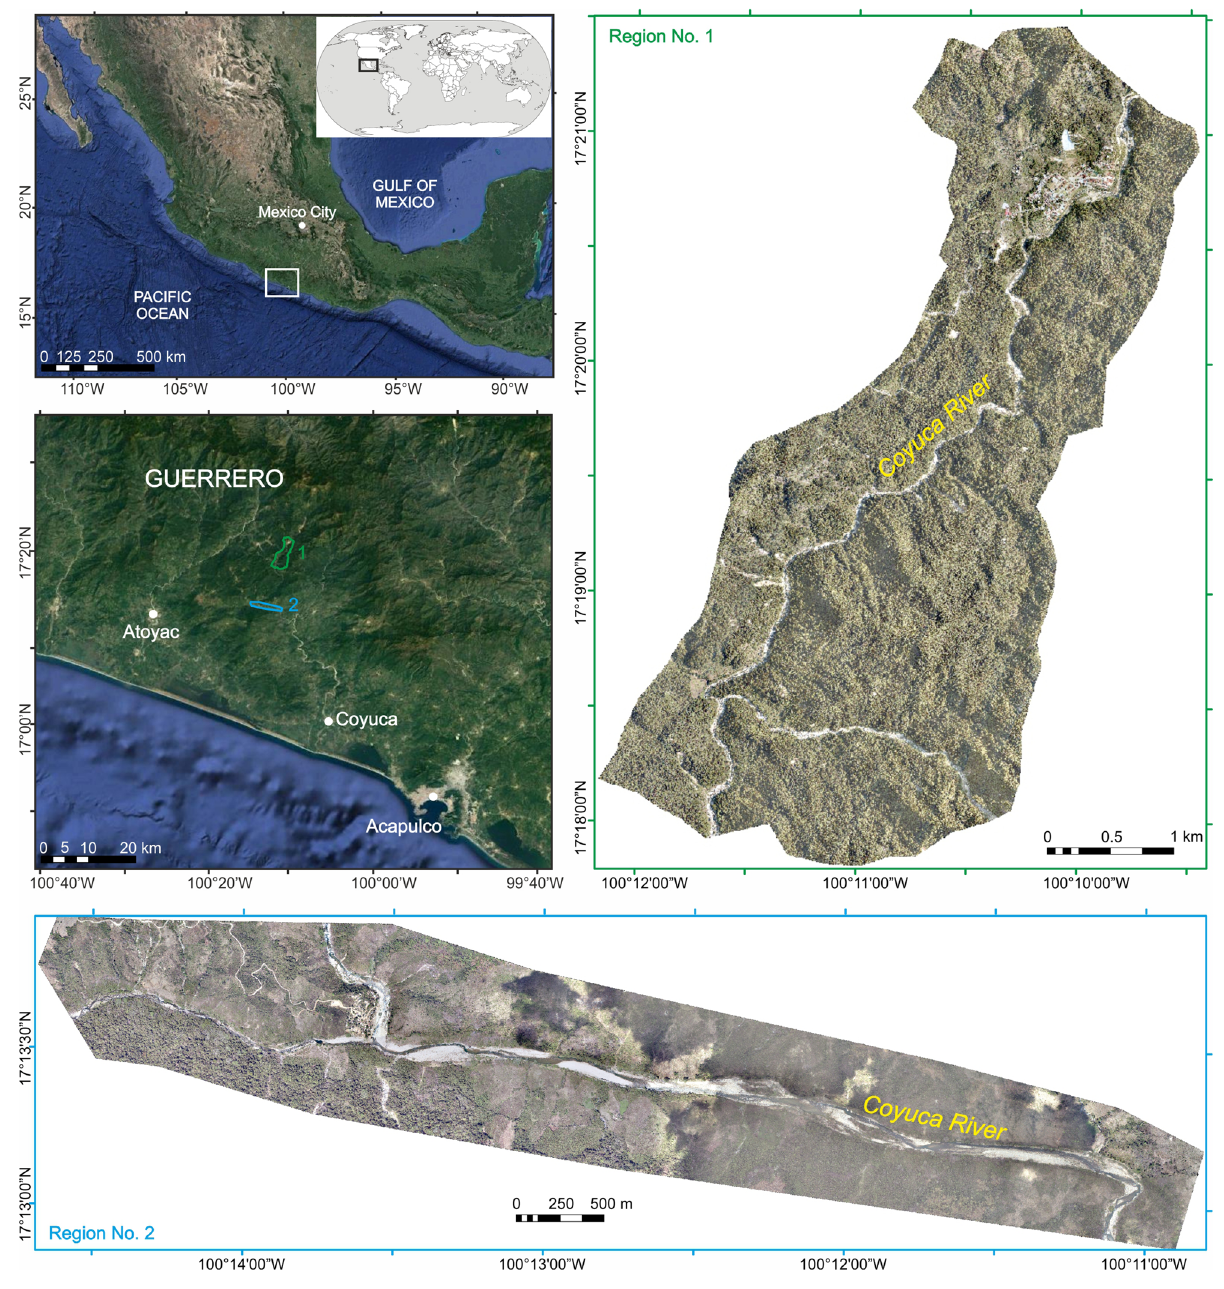
Figure 1. Orthophotomaps (10 cm resolution) of the studied regions, imposed on the shaded relief 1 m resolution LIDAR-derived digital terrain model (DTM), Coyuca drainage basin, southwest Mexico. Satellite images from Google Earth Pro 7.3 (Image © 2016 DigitalGlobe; https:// www. google. com/ intl/ en/ earth/). Maps were generated using ArcMap 10.2.2 software, copyright and licensed by ESRI (http:// deskt op. arcgis. com/ en/). The final layout was created in ArcMap 10.2.2 (http:// deskt op. arcgis. com/ en/) and CorelDRAW 2018 (https:// www. corel draw. com/ en/).